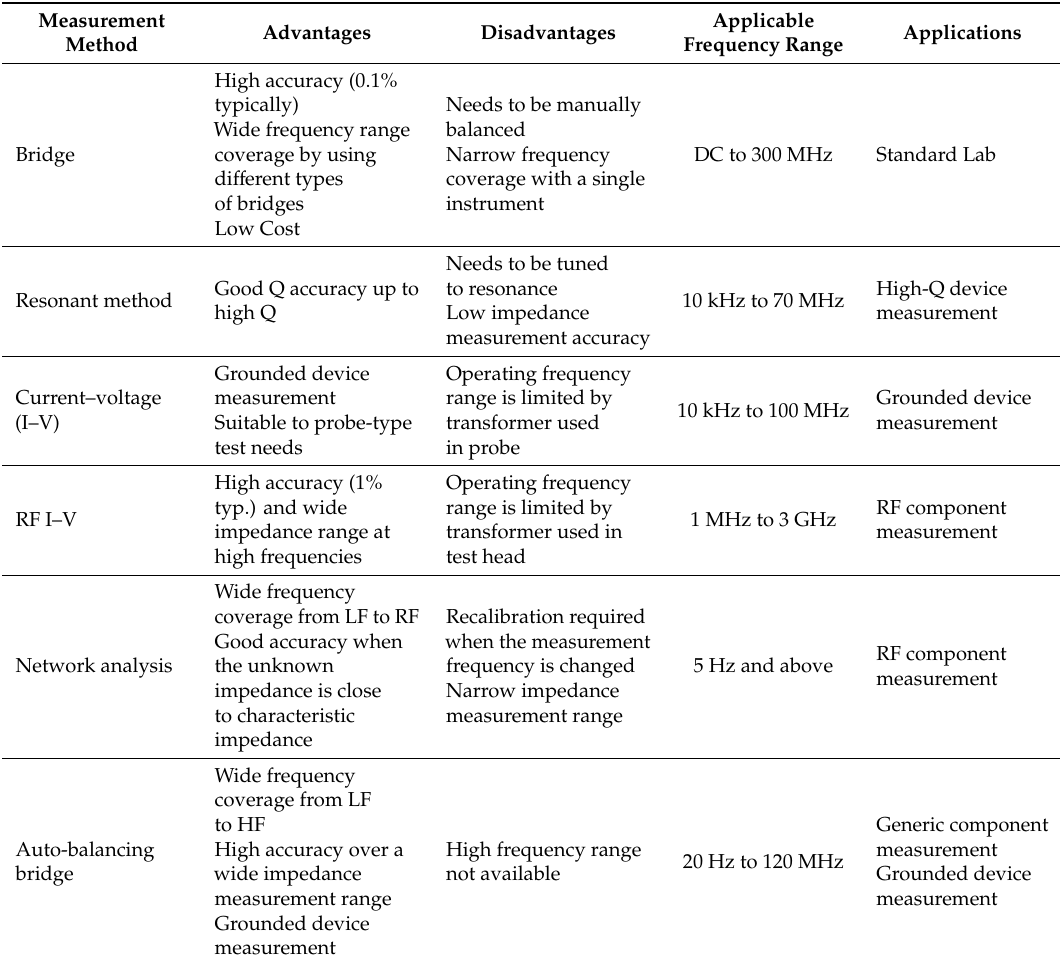
Table 1. Common impedance measurement methods [11]. Reproduced with permission, courtesy of © Keysight Technologies, Inc.,